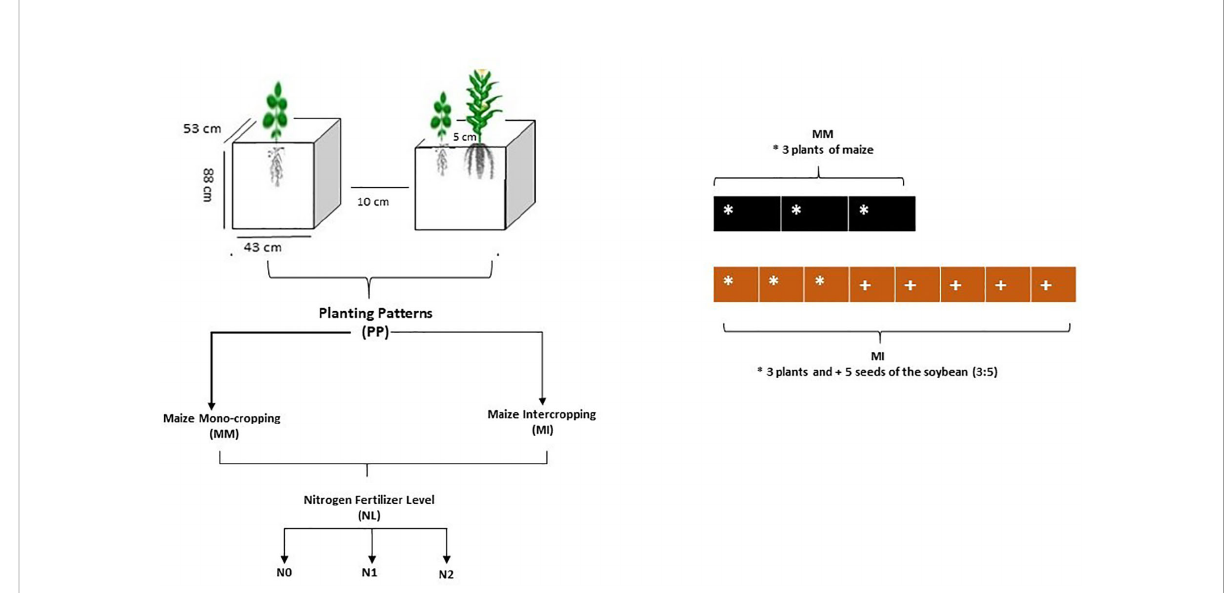
FIGURE 1 Schematic diagram of the experiment. N 0 ; 0 kg N ha -1 , N 1 ; 250 N kg ha -1 , N 2 ; 300 kg N ha -1 . * maize crop; + soybean